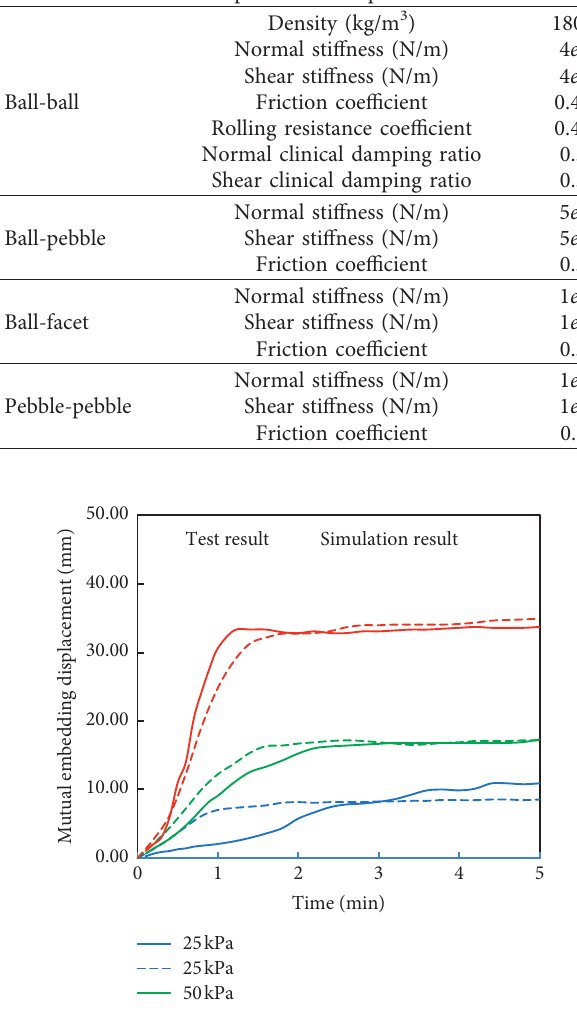
Figure 4: Comparison between simulation and test